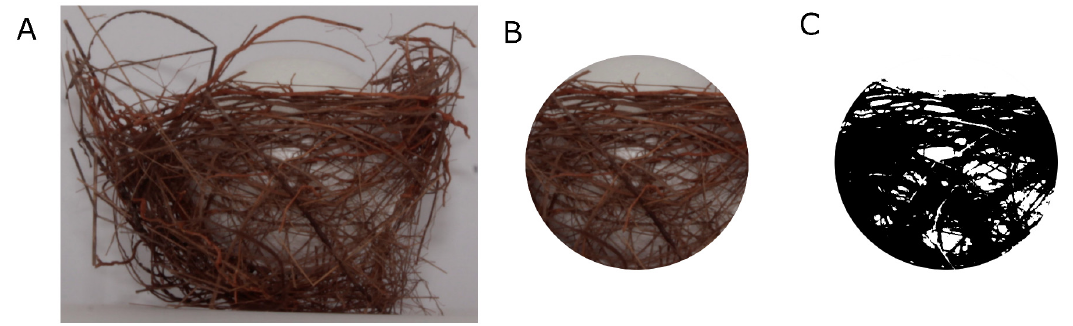
Figure 4. Description of how to produce an image to evaluate patterns in bird nest wall openness. The following example used a blue-black grasssquit ( Volatinia jacarina ) nest deposited in the museum collection Coleção Ornitológica Marcelo Bagno, at Universidade de Brasília (catalog number COMB-N682). A ) A photo of the nest was taken with a white styrofoam ball (50mm in diameter) placed inside the nest chamber. B ) In GIMP software (version 2.10.10), we added alpha channel (to allow transparent pixels), and used the Ellipse select tool to select contrast of the white ball and nest wall, and then erased all background elements. C ) To ensure that shadows from nest wall did not influence white ball detection, we also performed the threshold processing in GIMP. To preserve the transparent pixels from background elements, the final image must be saved as a PNG